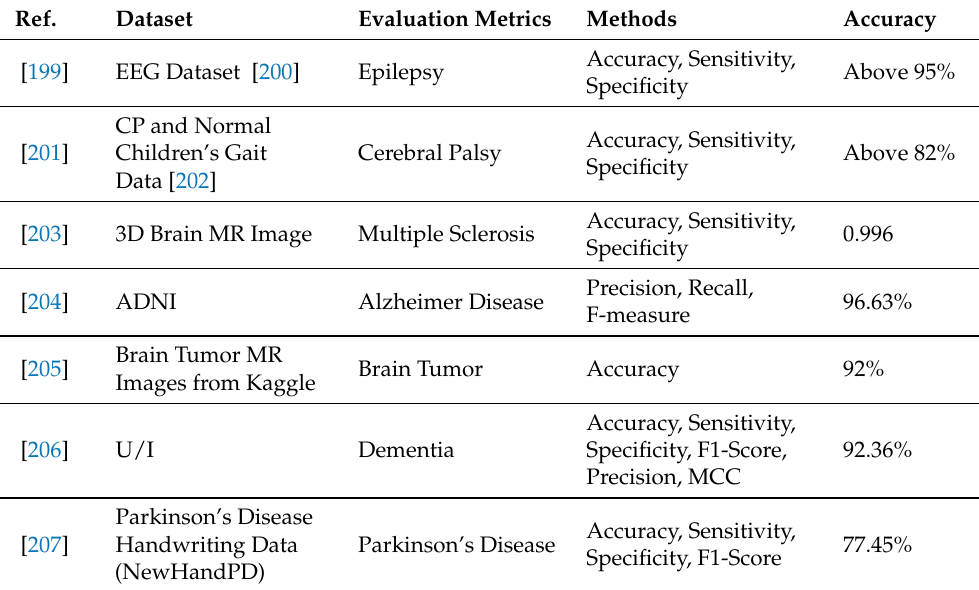
Table 8. A tabulation of result analysis of SVM classifier.